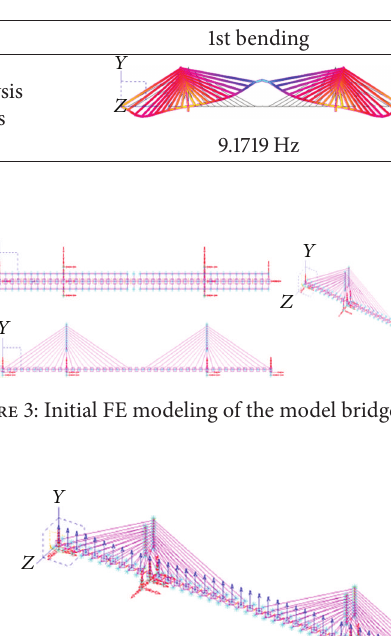
Figure 2: Steps for tensioning the cables of the cable-stayed bridge model. Table 3: FE analysis results of the cable-stayed bridge model.